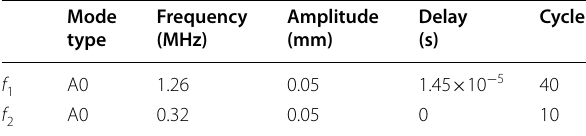
Table 2 Parameters of excitation signal